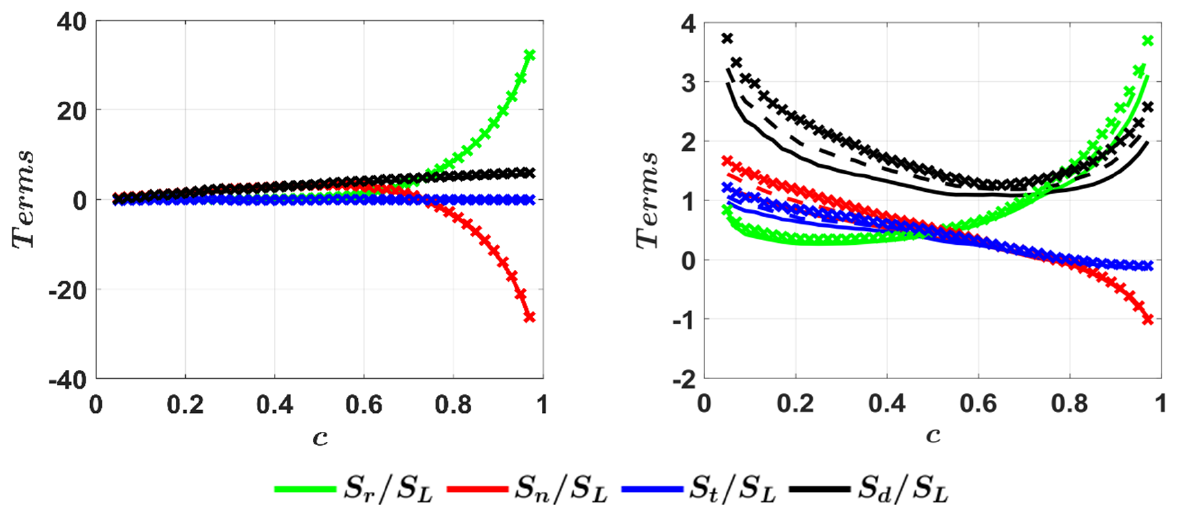
Figure 8. Profiles of the mean values of S d / S L and its components (i.e., S r / S L , S n / S L and S t / S L ) conditioned upon c for u (cid:48) / S L = 4.0 (solid line) 6.0 (broken line) and 8.0 (cross marker) for statistically planar turbulent premixed flames (first column) and homogeneous MILD combustion cases (second column). Note the difference in scales between premixed flame and MILD combustion cases.